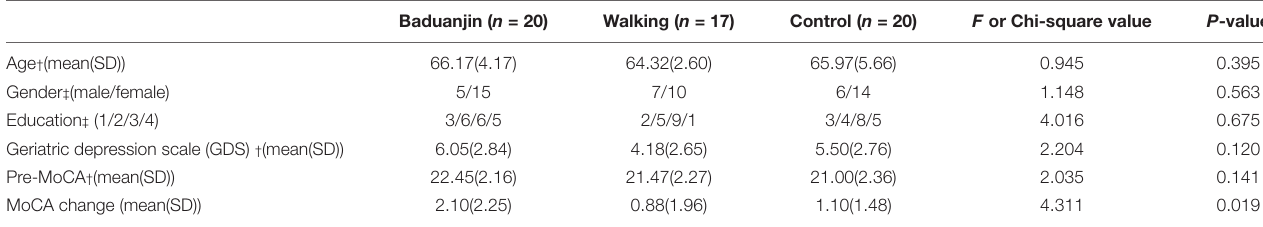
TABLE 1 | Demographics of study participants and clinical outcome